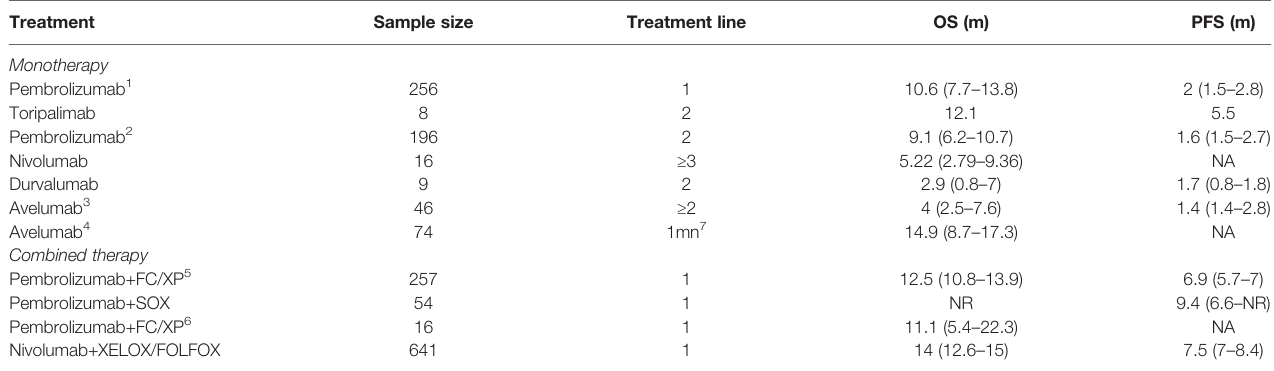
TABLE 3 | Survival information of patients with PD-L1 CPS ≥ 1 receiving immunotherapy. Treatment Sample size Treatment line OS (m) PFS